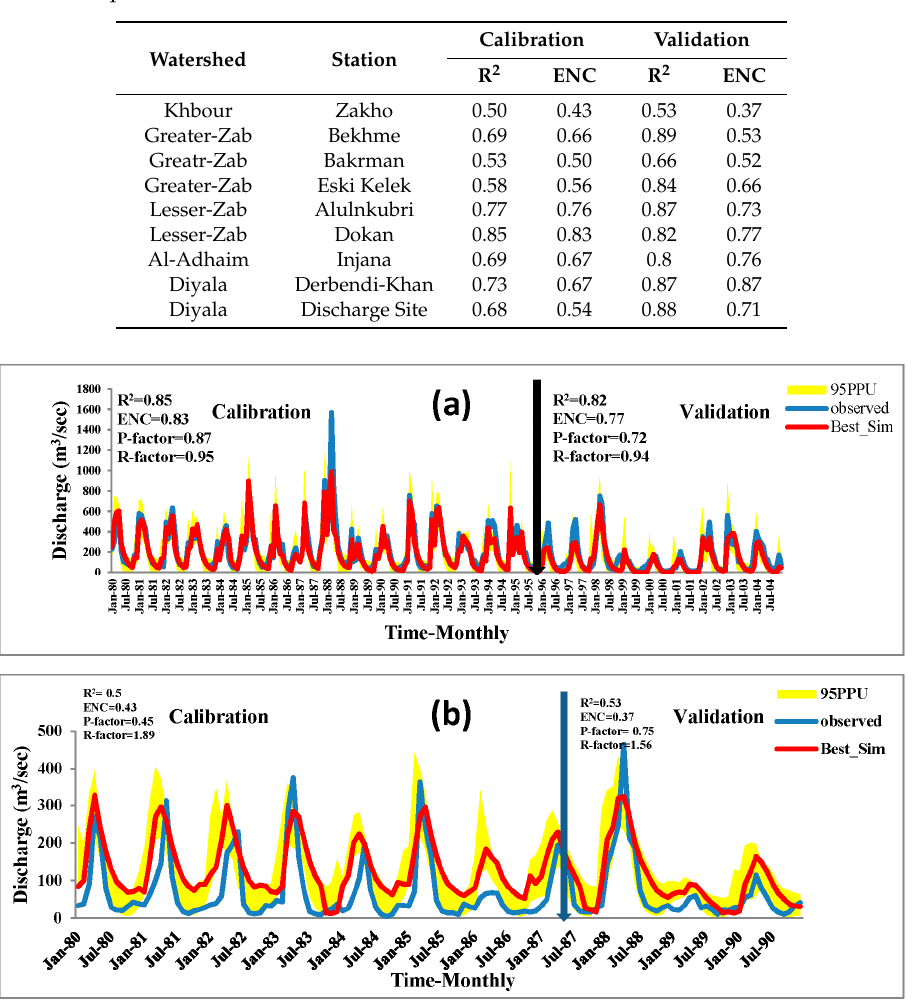
Table 4. The statistical index values (R 2 and ENC) at the nine discharge stations within the five basins of northeast Iraq.